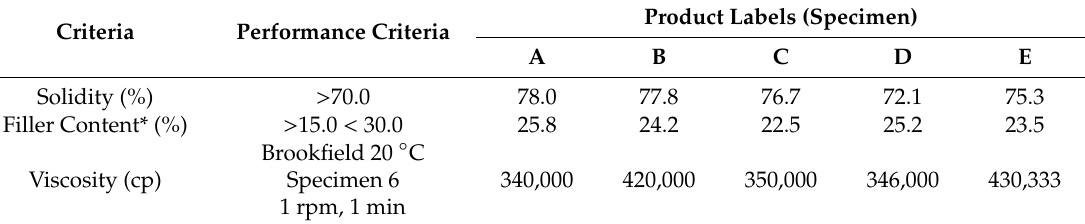
Table 3. Five ENC-SPRG specimen